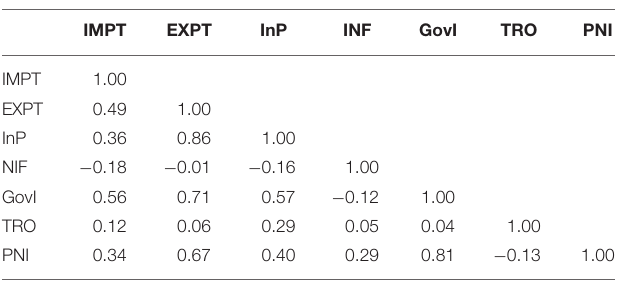
TABLE 2 | Correlation analysis.